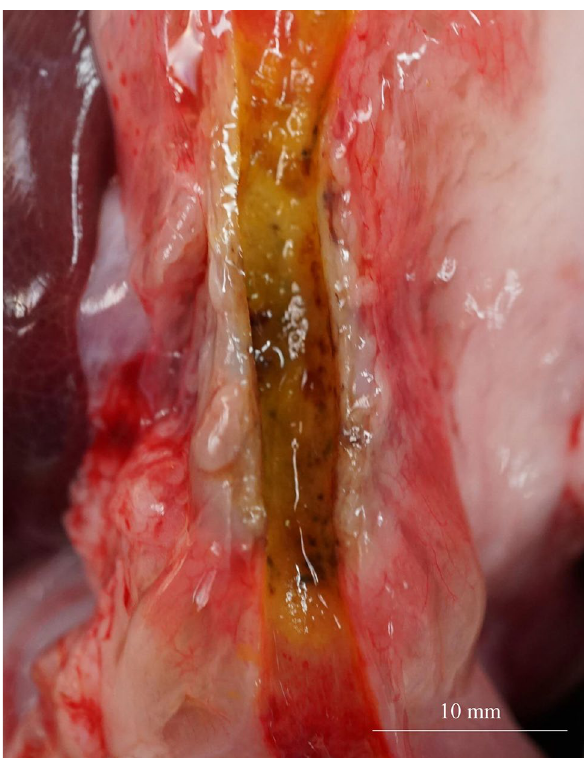
Figure 5. Macroscopic image of the bile duct after balloon-based radiofrequency ablation. The mucosa at the site of ablation appeared dark-brown compared to that surrounding the normal bile